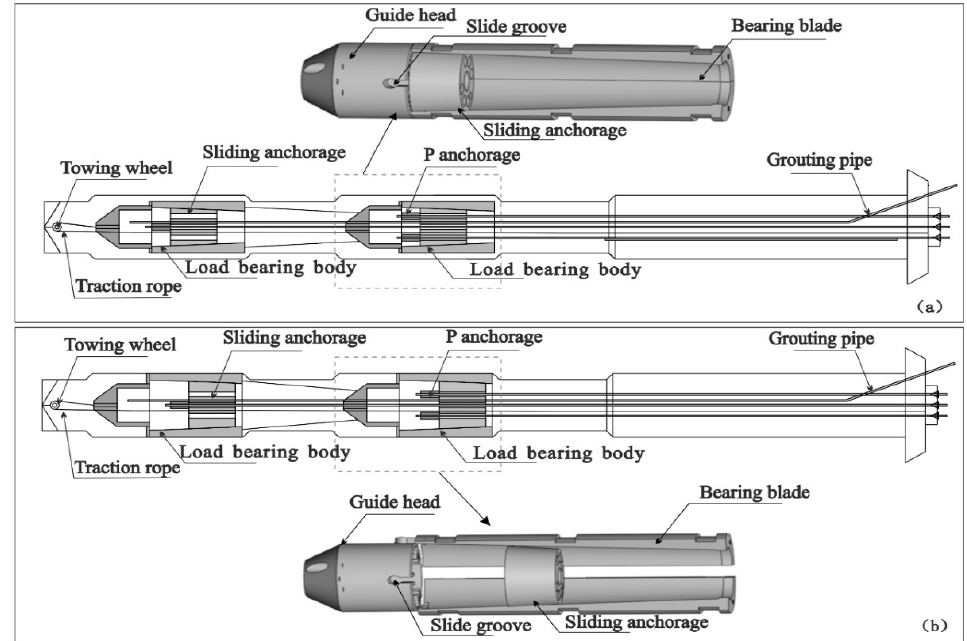
Figure 1. Schematic diagram of the MSEA structure. ( a ) The initial state; ( b ) the lock-off state.